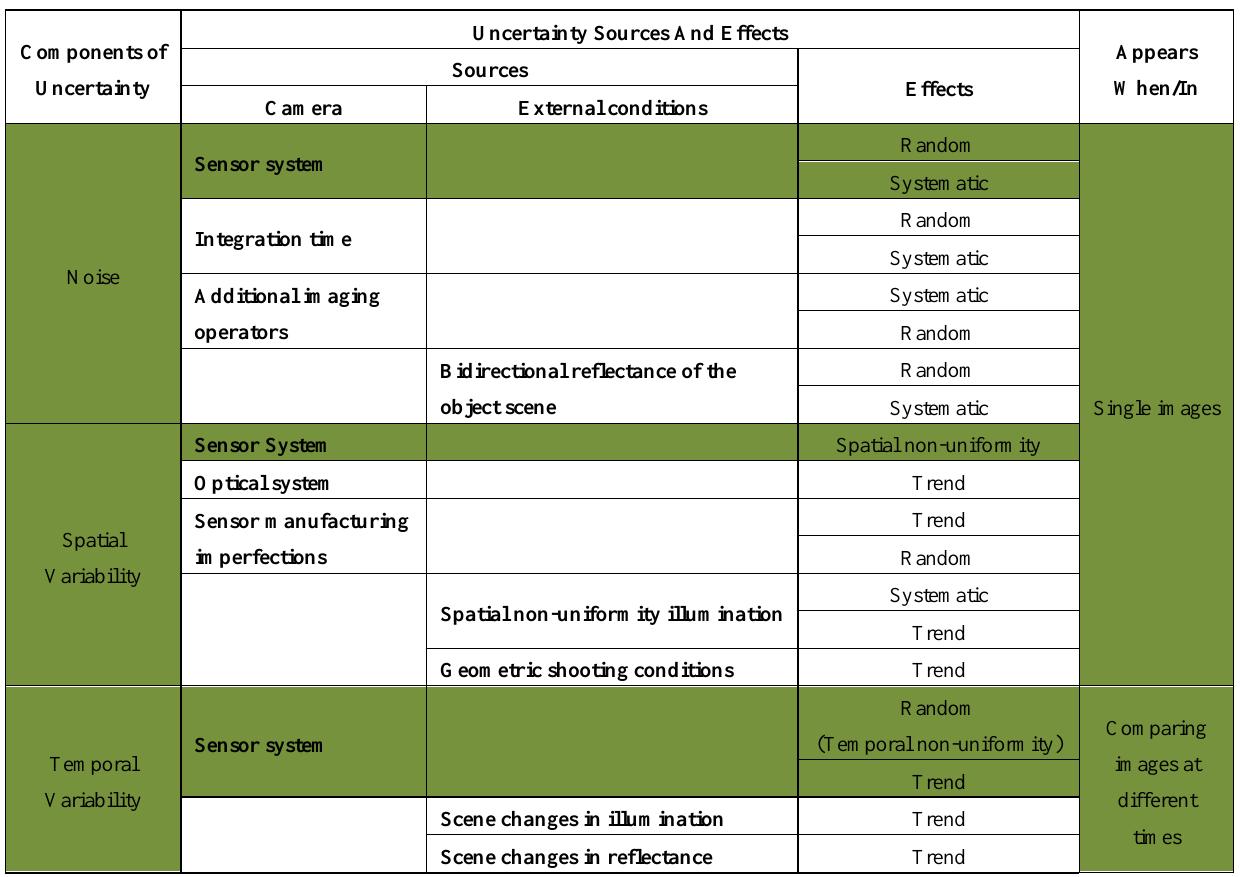
Table 1. Outline of the most important uncertainty sources and effects affecting the radiometric values in digital cameras. The uncertainty sources analyzed in this paper are